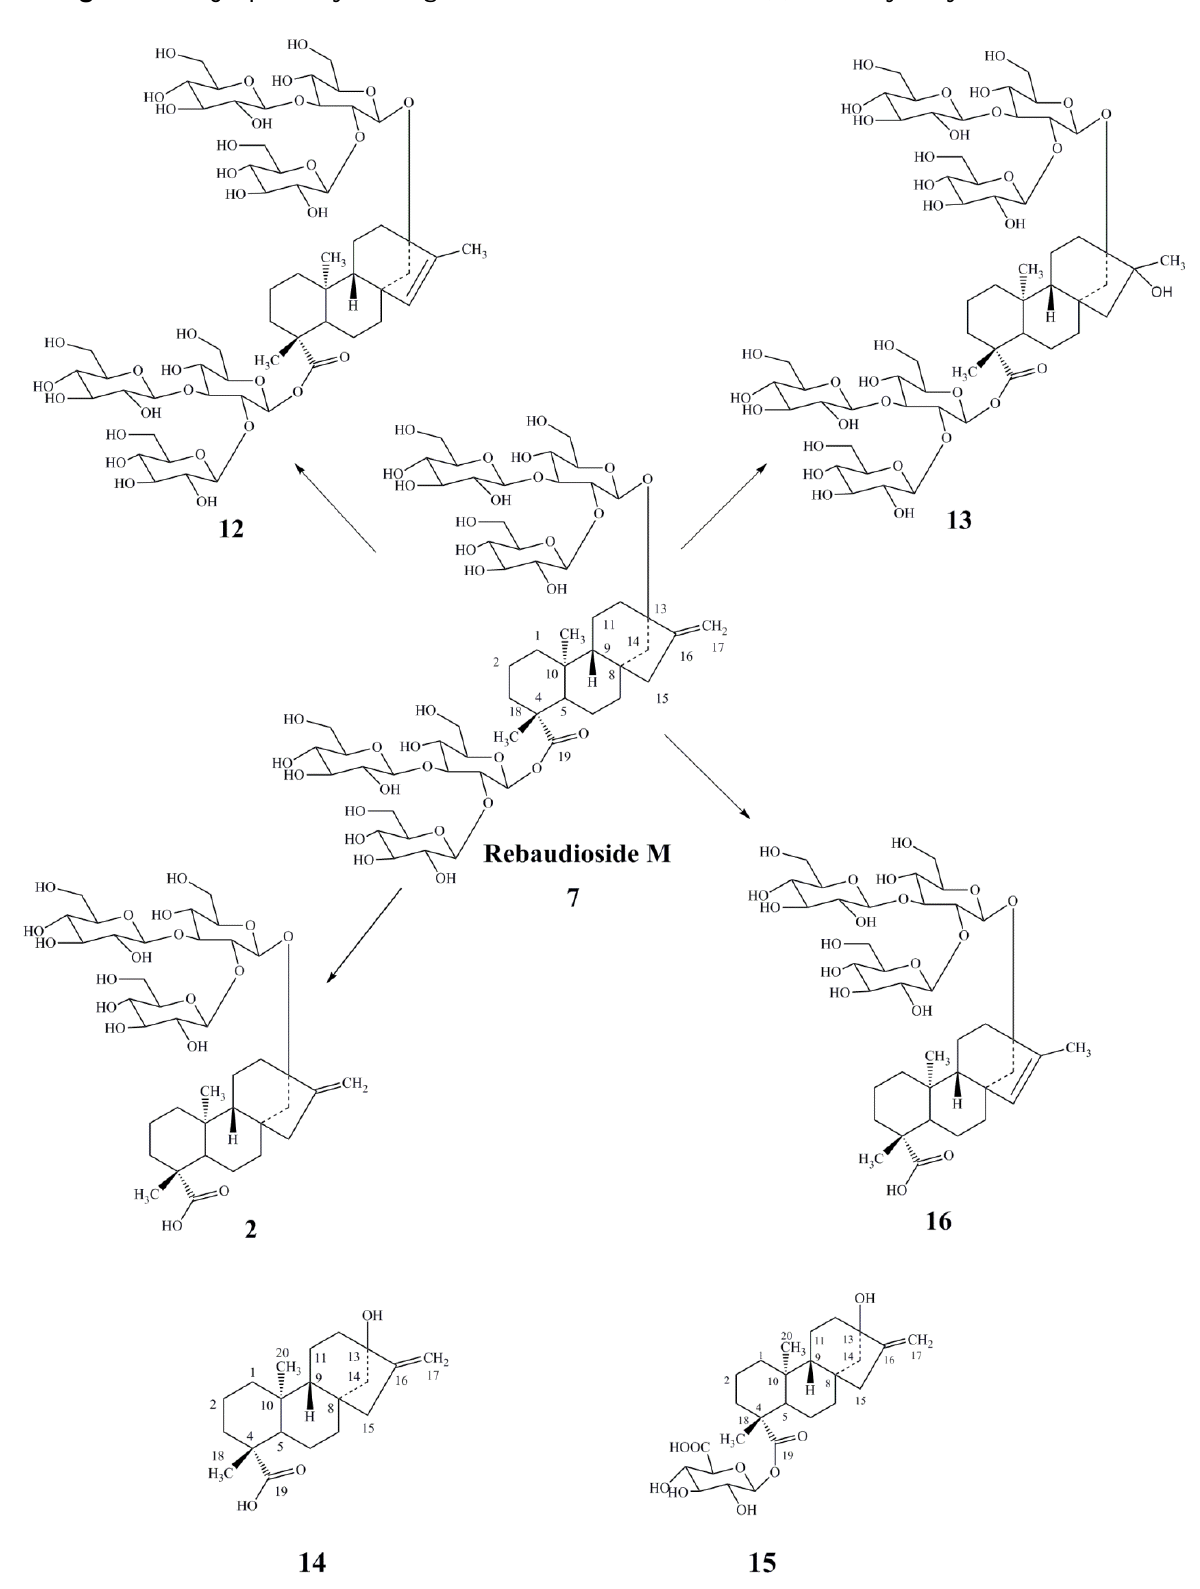
Figure 3. Major pathways of degradation of rebaudioside M ( 7 ) under hydrolytic